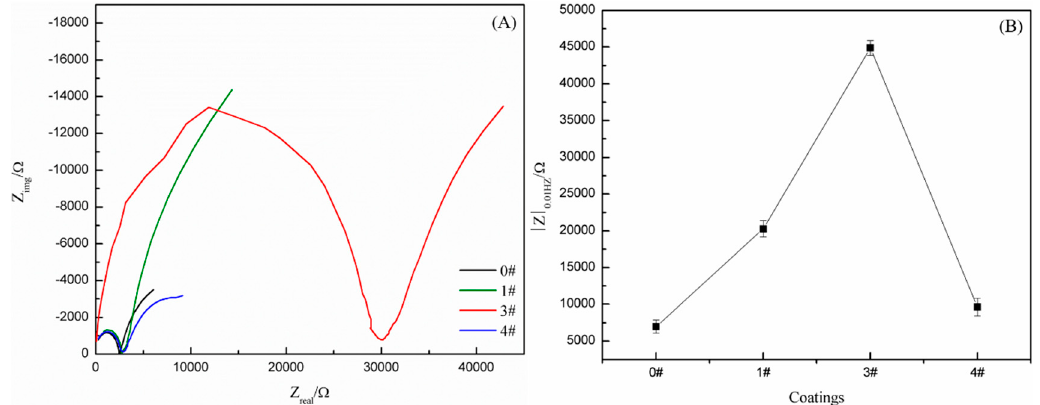
Figure 6. ( A ) Nyquist plots and ( B ) |Z| 0.01Hz values of different SHWPUCs after an immersion in 3.5 wt % NaCl solution at 40 °C for 30 days.